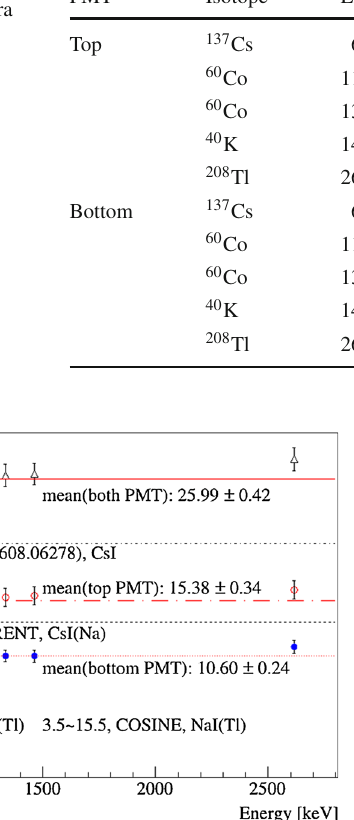
Table 2 Summary of γ -ray peaks in the calibration spectra